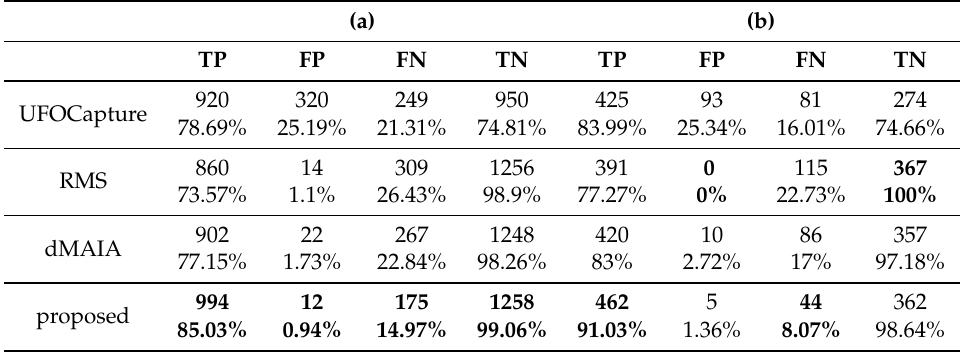
Table 2. Confusion matrix based on frame classification. (a) Analysis of all available video sequences. (b) Analysis of the video sequences capturing events longer than 25